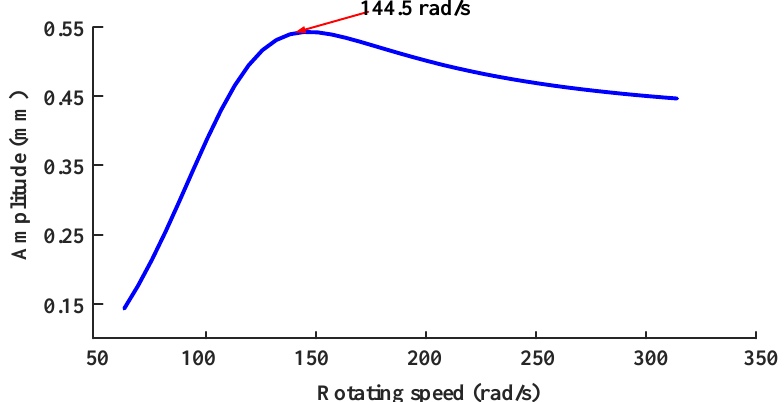
Figure 2. Amplitude response curve of the disk in the x -direction.